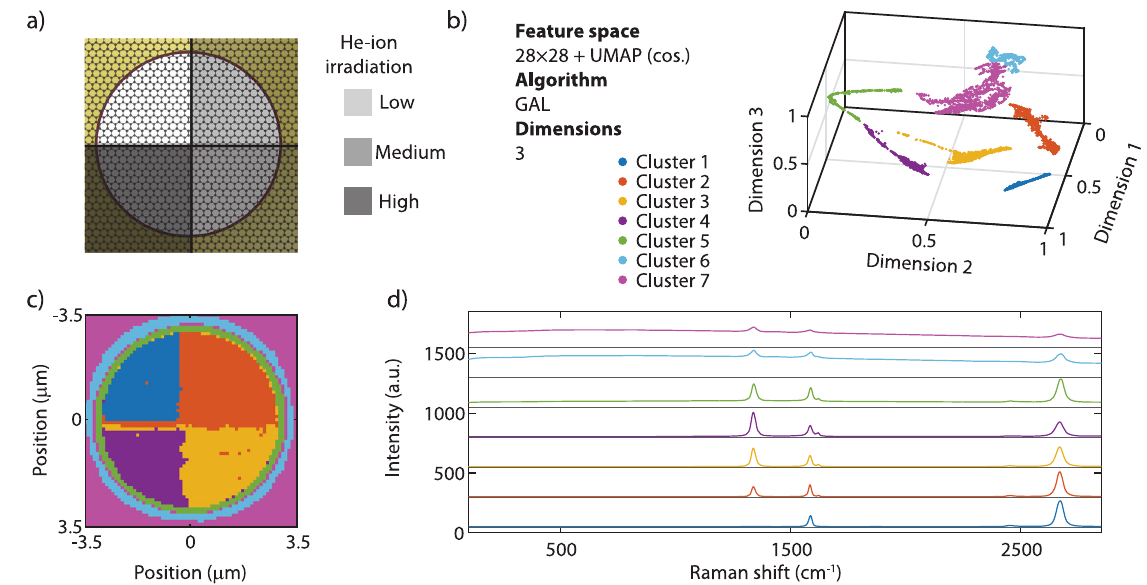
Fig. 5 Application of the method on Raman spectra. a Sample layout: suspended graphene membrane irradiated with four different He-ion doses. b Partitioned feature space, constructed with 28 × 28 + uniform manifold approximation and projection (UMAP) using the cosine (cos.) distance metric and the graph average linkage (GAL) clustering algorithm. c Spatial map of the extracted clusters. d Average Raman spectrum of each